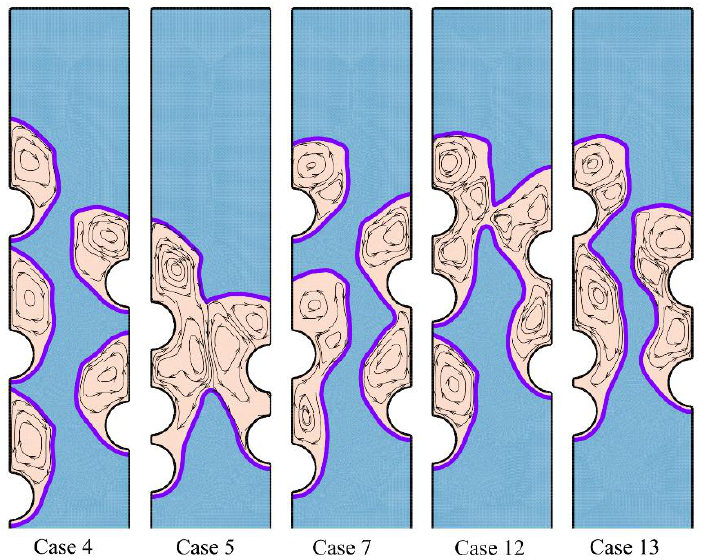
Figure 6. The streamlines and phase change interfaces for five different tubes ’ arrangement after one hour of charging. Case 4 is the optimum case with the highest melting rate.